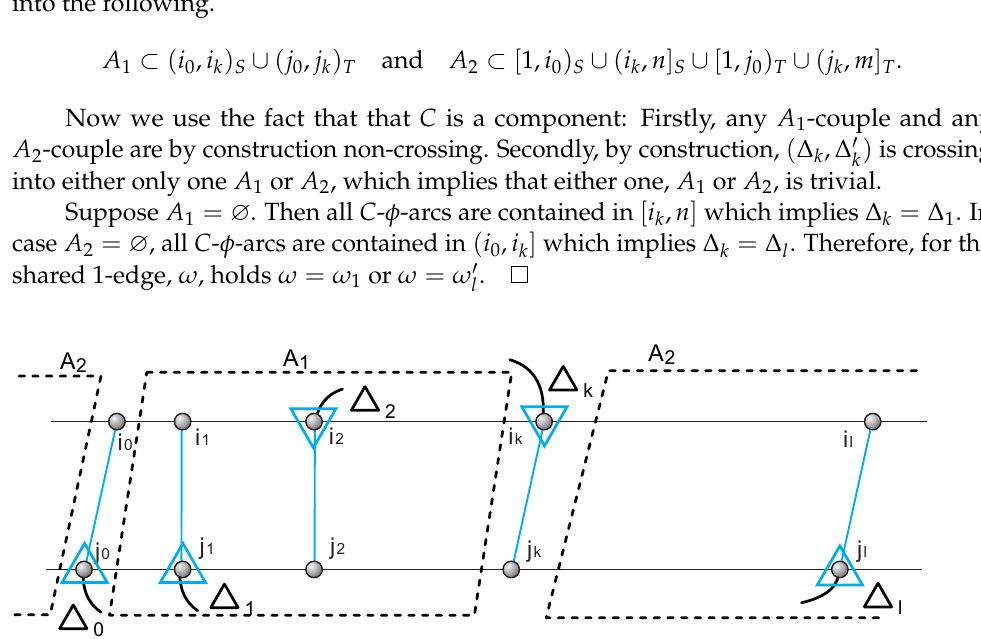
Figure 9. The fact ∆ 0 ∩ ∆ k = ω organizes C -couples into two subsets A 1 ⊂ ( i 0 , i k ) S ∪ ( j 0 , j k ) T and A 2 ⊂ [ 1, i 0 ) S ∪ ( i k , n ] S ∪ [ 1, j 0 ) T ∪ ( j k , m ] T , marked by dashed